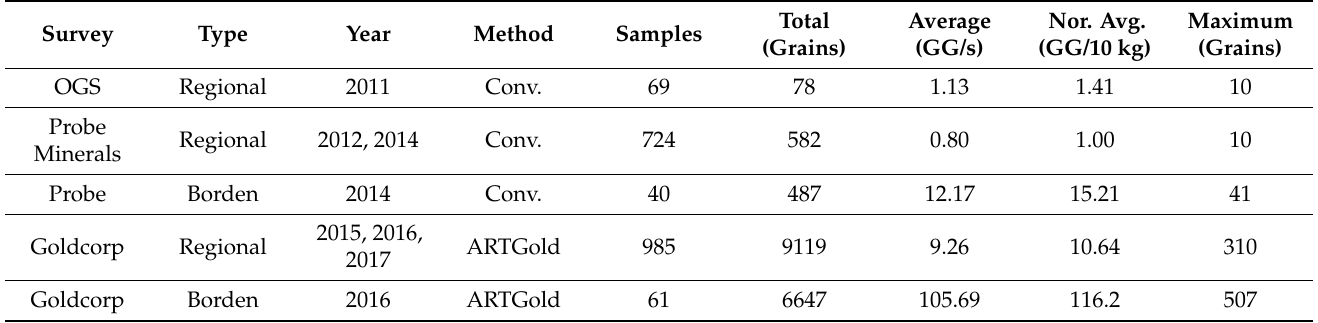
Table 1. Statistics on the gold grain counts from the various surveys used in the current